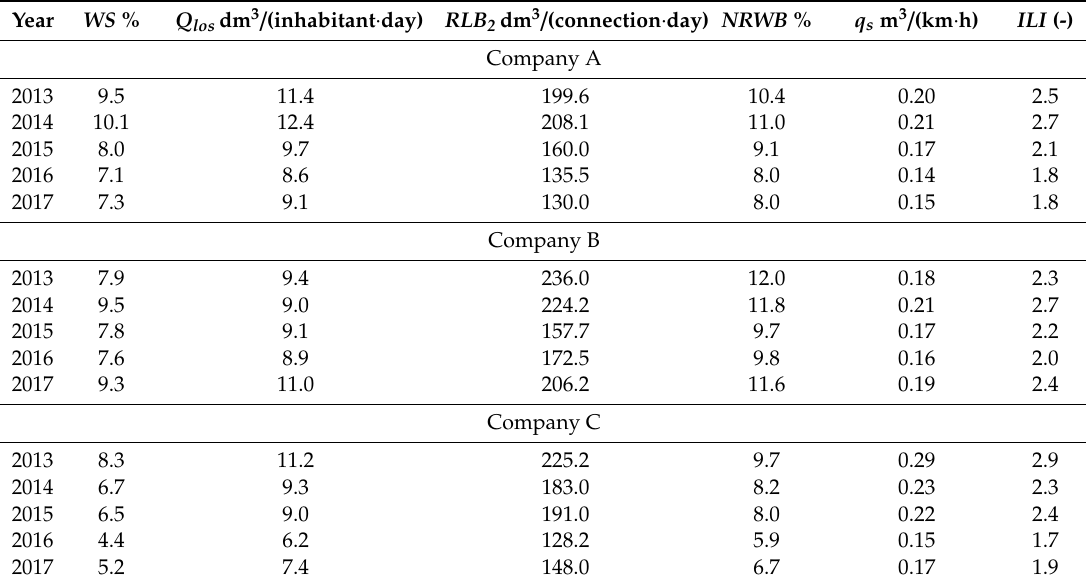
Table 4. Water loss indices for the analysed